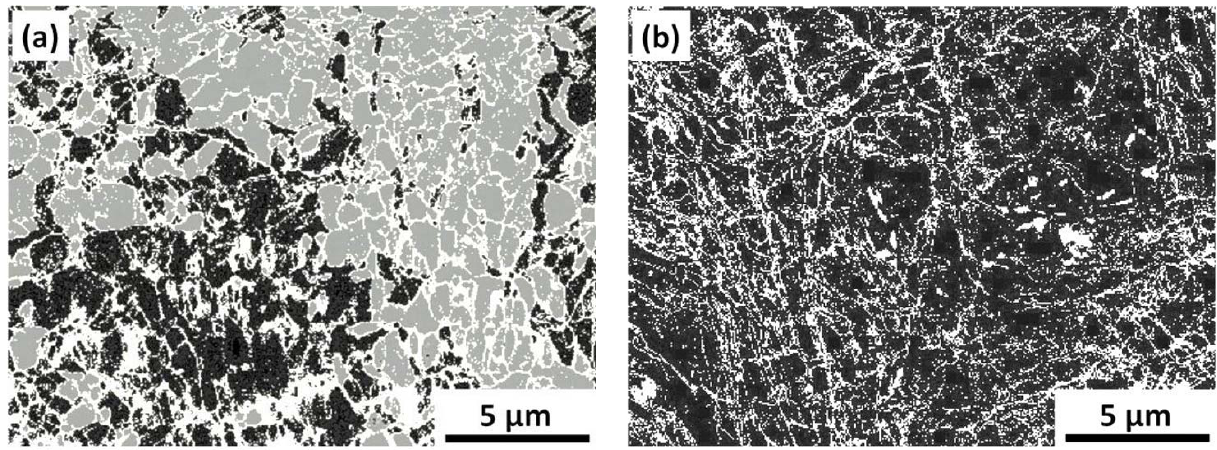
Figure 3. Phase contrast images obtained by EBSD showing the microstructure evolution following tests at the largest plastic strain amplitude of 5 × 10 − 3 ( a ) and smallest plastic strain amplitude of 5 × 10 − 4 ( b ). Black = austenitic phase, light grey = martensitic